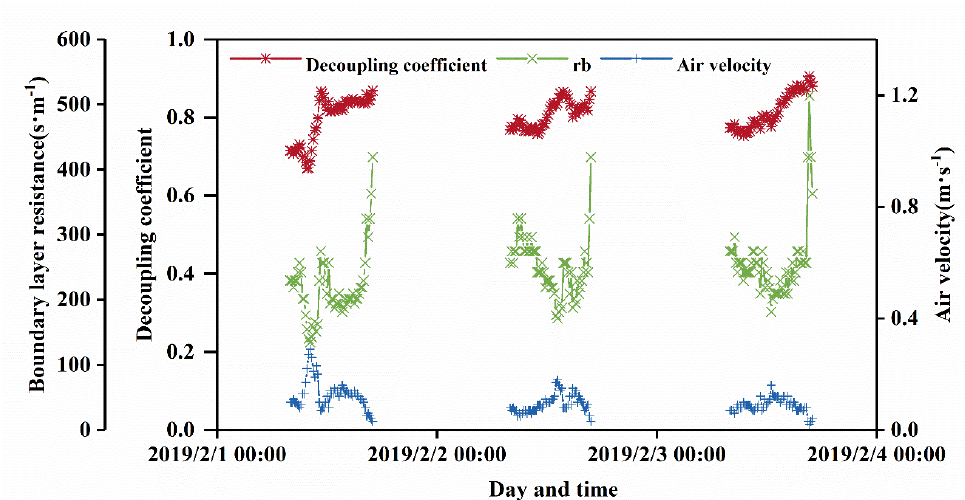
Figure 10. Decoupling coefficient, air velocity and boundary layer resistance during daytime inside the sunken solar greenhouse in three sunny days from 1 to 3 February in 2019.